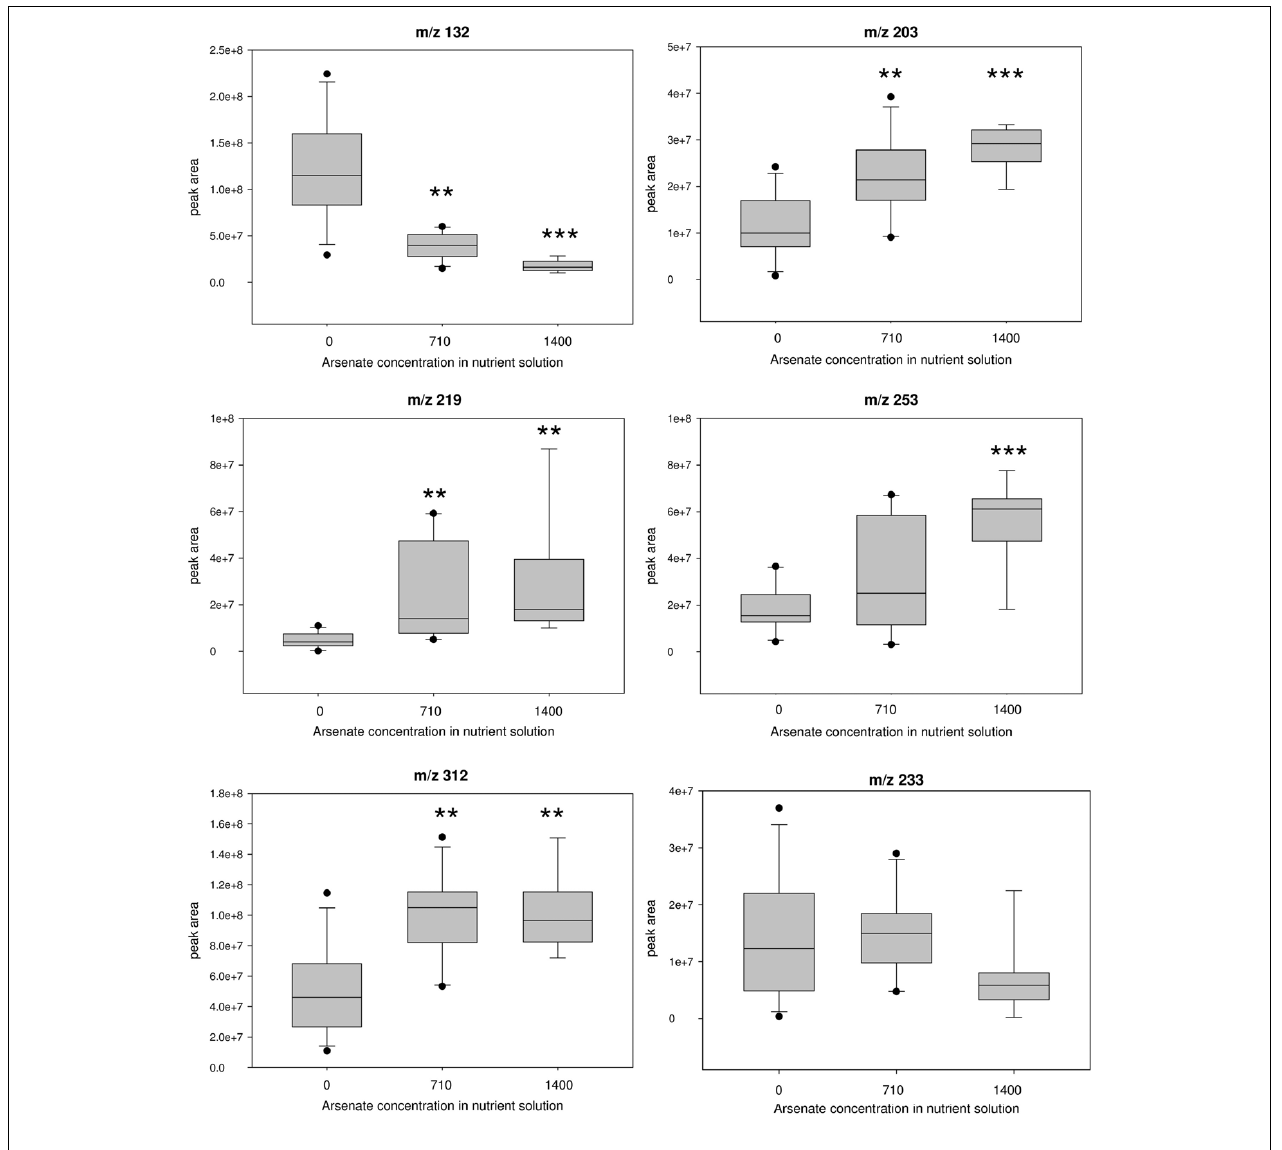
arsenic, 710 and 1400 μ gkg − 1 arsenate. Statistical significance according to: P > 0.05 (ns), * P = 0.01–0.05, ** P = 0.001–0.01, *** P < 0.001 ( n =